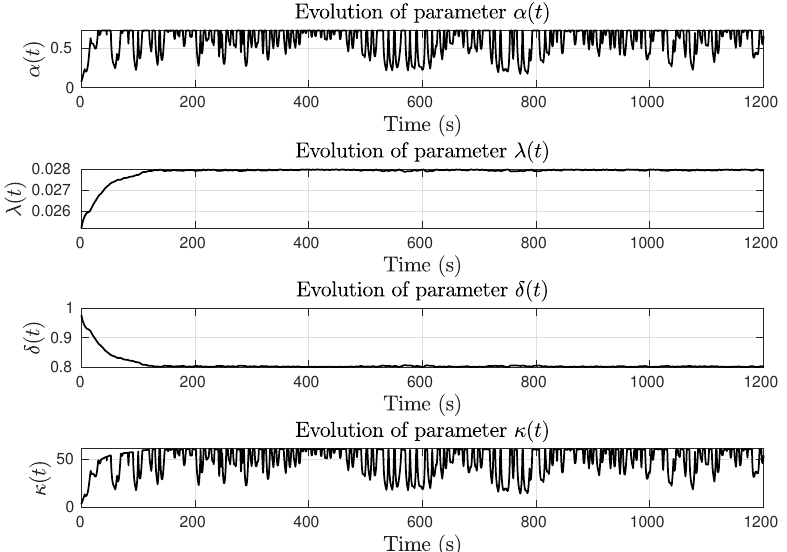
Figure 13. Sinusoidal yaw reference test with d ( t ) (cid:54) = 0. Adaptive parameters